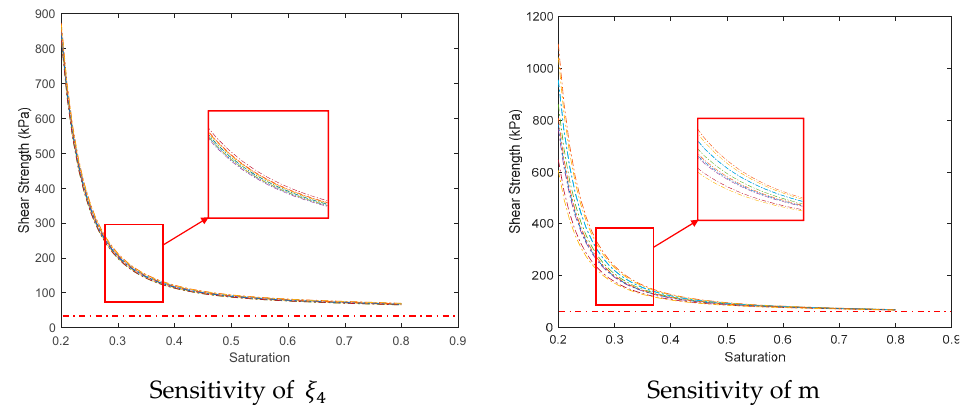
Figure 25. Comparison for sensitivity of the four parameters.